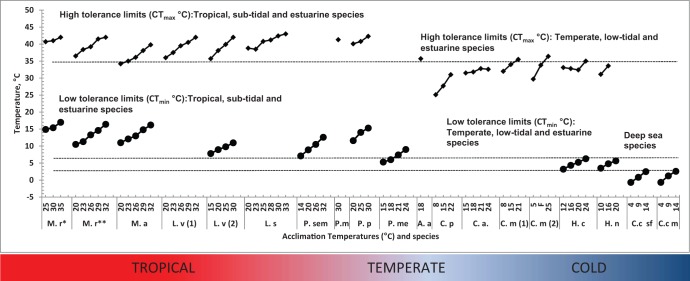
CTmax and CTmin of different crustaceans that occur in tropical, temperate and deep sea cold habitats, including H. crenulatus. Dotted lines indicate the frontiers that separate low and high limits of tolerance at high and low temperatures, depending on the habitat of the species. Temperate species have a CTmax limit around 35°C that corresponded with the low CTmax limit of tropical species (34–36°C). Tropical species showed a CTmin limit around 9°C similar to the maximum CTmin of temperate species (5–6°C). The maximum CTmin of deep sea species (2.5°C) that occur in cold environments matched the low CTmin values (3.2°C) of temperate species. M.r*, Macrobrachium rosenbergii (Manush et al., 2004); M.r**, M. rosenbergii (Díaz Herrera et al., 1998); M.a, M. acanthurus (Díaz et al., 2002); L.v(1), Litopenaeus vannamei (González et al., 2010); L.v(2), L. vannamei (Kumlu et al., 2010); L.s, L. stylirostris (Re et al., 2006); P.sem, Penaeus semisulcatus (Kir and Kumlu, 2008); P.m, Penaeus monodon (Ern et al., 2015); P.p, Portunus pelagicus (Qari and Aljarari, 2014); P.me, Penaeus merguiensis (Hoang et al., 2002); A.a, Astacus astacus (Ern et al., 2015); C.p, Cancer pagurus, and C.m(1), Carcinus maenas (Cuculescu et al., 1998); C.a., Cancer antenarius (Padilla-Ramírez et al., 2015); C.m (2), C. maenas, including field data from California (F) (Tepolt and Somero, 2014); H.c, Hemigrapsus crenulatus (this study); H.n, H. nudus (McGaw, 2003); C.c sf., Crangon crangon spent females and C.c m., C. crangon males (Reiser et al., 2014a,b).